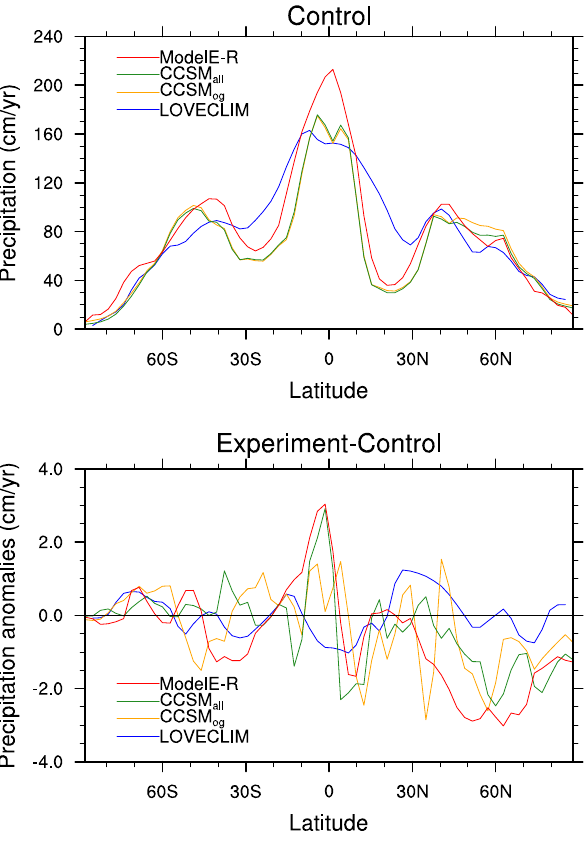
Fig. 11. (Top) Annual-mean precipitation zonally-averaged across the Atlantic (90 ◦ W–40 ◦ E) in the control simulation, in cmyr − 1 . (Bottom) Anomalies of Atlantic annual-mean precipitation for the first fifty years following the MWP relative to the control simula- tion, in cmyr − 1